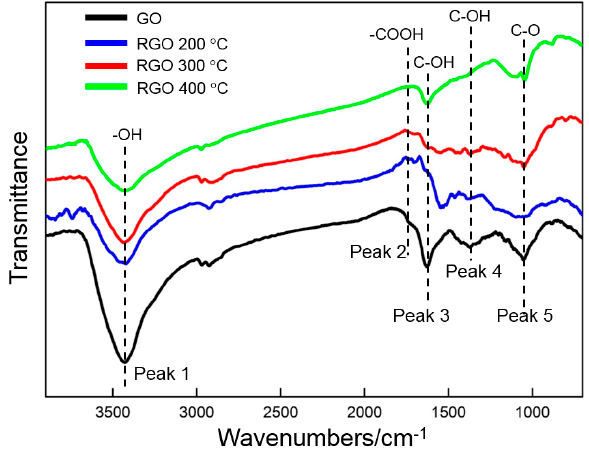
Figure 7. FTIR curves of GO before and after thermal reduction at different temperatures.